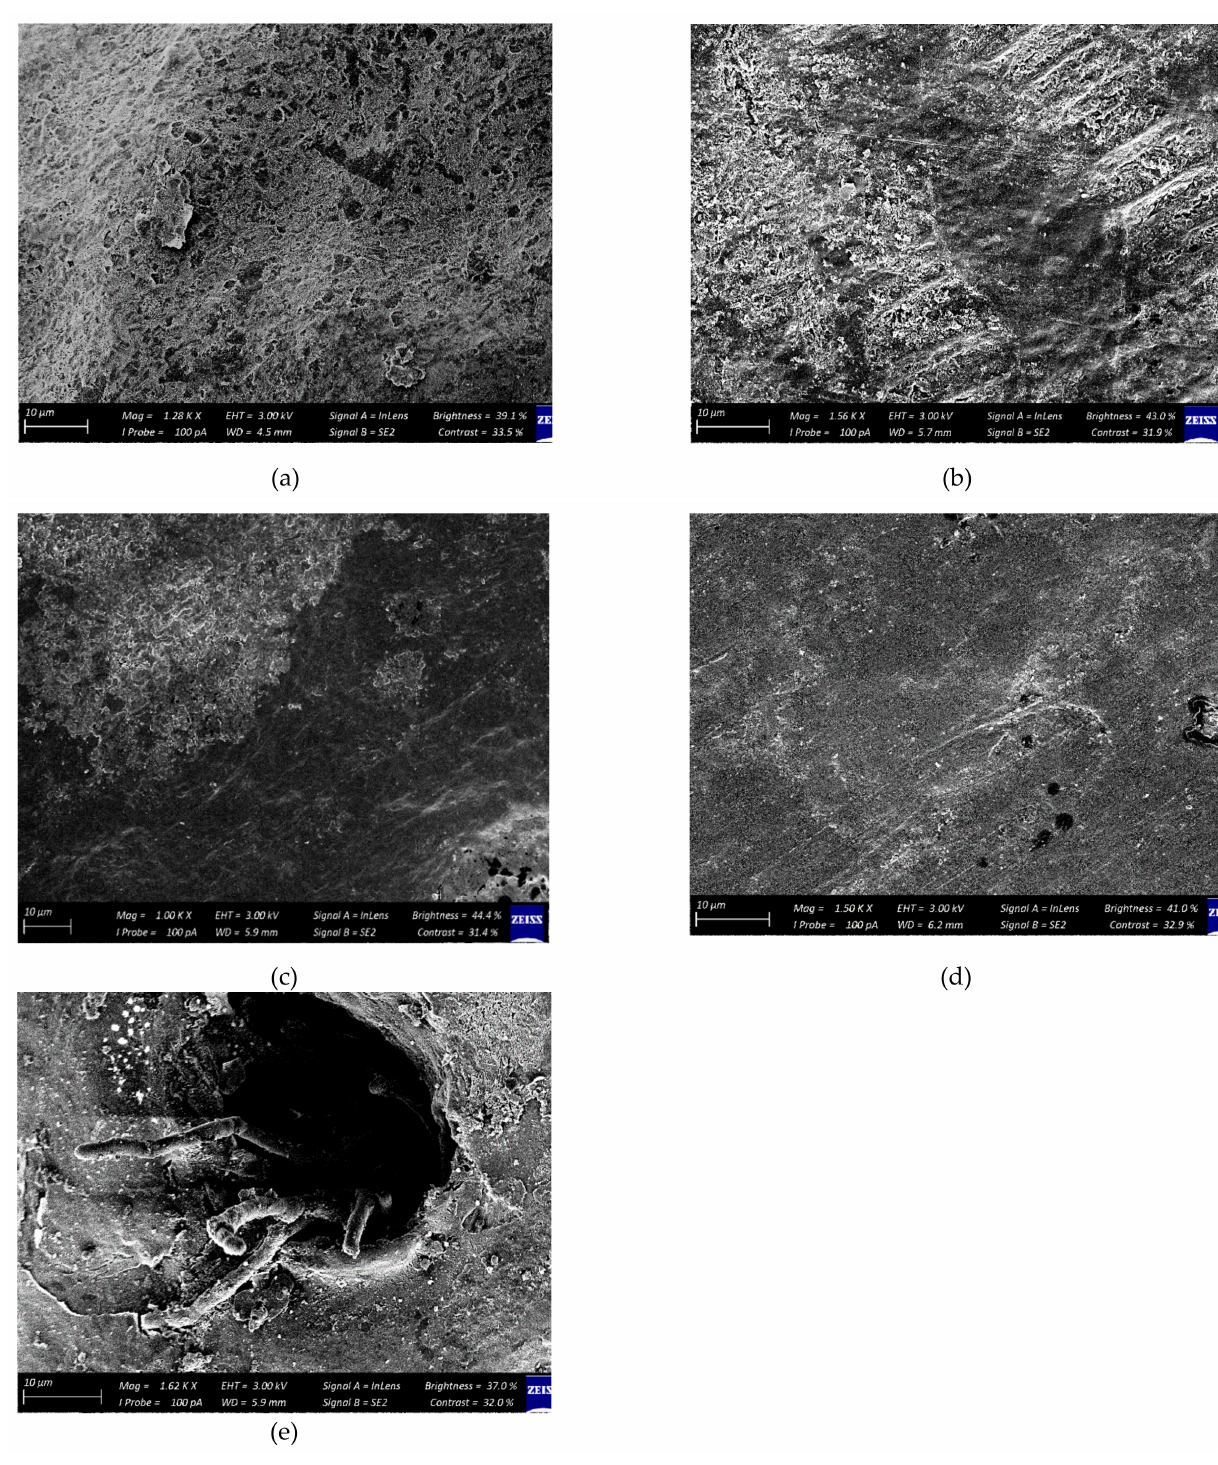
Figure 3. Scanning electron micrographs of ‘Wonderful’ pomegranate peel after 6 weeks of cold storage at 5 ◦ C. ( a )—gum arabic (GA); ( b )—gum arabic + lemongrass oil (GA + LM); ( c )—gum arabic + pomegranate peel extract (GA + PP); ( d )—gum arabic + lemongrass oil + pomegranate peel extract (GA + LM + PP); ( e )—Uncoated